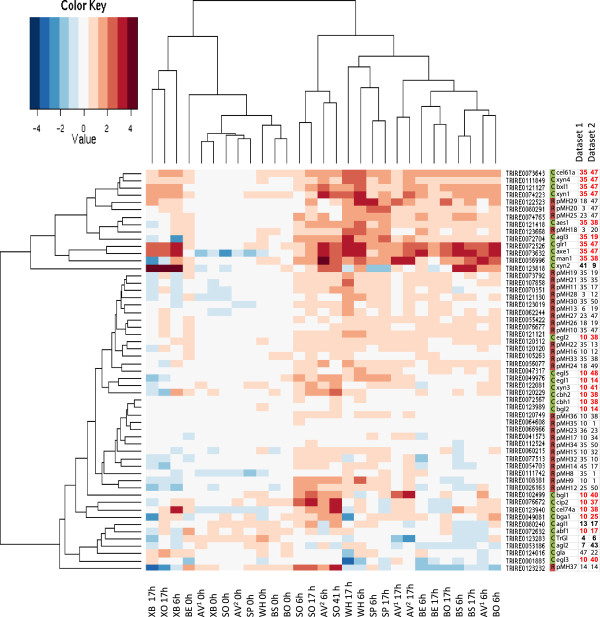
Heat map visualization of expression data on the known cellulase and hemicellulase genes and the putative regulatory genes in cultures induced with different lignocellulose substrates. The color key indicates the log2 scale fold change of the transcript signals in the induced cultures versus the uninduced control cultures at the same time point. The genes are shown as rows and the samples as columns. The legend on the right shows the gene ID and the cluster membership of the gene in Mfuzz clustering of the expression datasets. Dataset 1: Induction experiment with Avicel cellulose (0.75%), pretreated wheat straw, pretreated spruce or sophorose; Dataset 2: Induction experiment with Avicel cellulose (1%), bagasse, or xylans [8]. C: CAZy gene, R: regulatory gene. The legend below indicates the lignocellulose substrate in the culture and time point after addition of the substrate. AV1, 0.75% Avicel cellulose; AV2, 1% Avicel cellulose; BE, enzymatically hydrolyzed bagasse material; BO, untreated bagasse material; BS, steam-exploded bagasse material; SO, sophorose; SP, spruce; WH, wheat straw; XB, birch xylan; XO, oat spelt xylan.